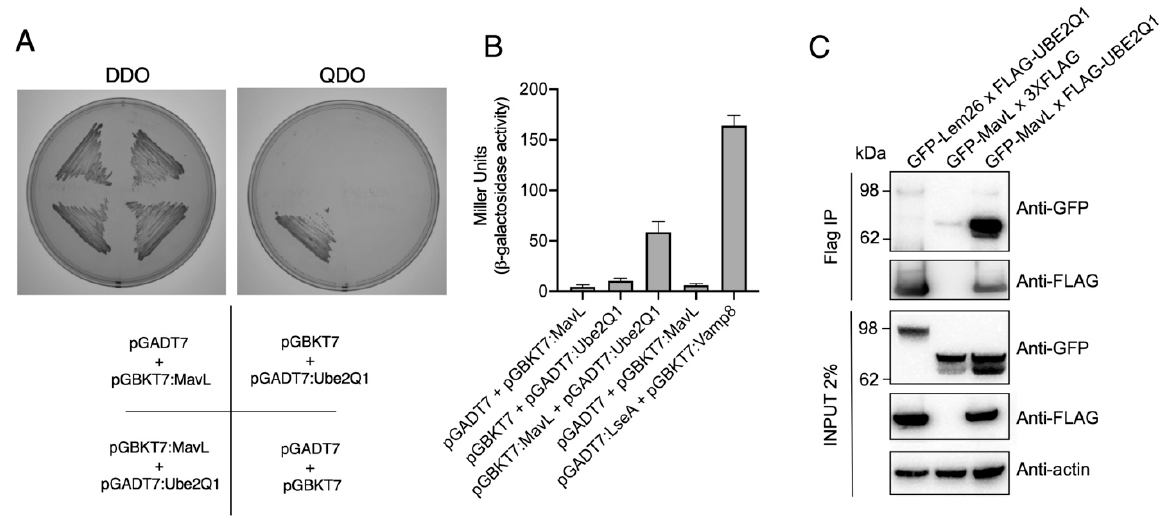
Figure 2. Protein-protein interaction between MavL and UBE2Q1. ( A ) Yeast two-hybrid analysis of protein-protein interactions in S. cerevisiae PJ69-4A. Growth on selective media for plasmid maintenance (DDO, double dropout) or selective media for interaction between proteins (QDO, quadruple dropout). Interactions on QDO shown for yeast strains carrying pGADT7:Ube2Q1 and pGBKT7:MavL. ( B ) β -galactosidase reporter activity for yeast strains shown in ( A ), and positive control carrying plasmids pGADT7:LseA and pGBKT7:Vamp8. LseA and Vamp8 are known interaction partners [13]. Activity is shown in Miller Units. ( C ) Immunoprecipitation of HEK293T cells transfected with pFLAG-UBE2Q1 and pGFP-MavL. Anti-FLAG immunoprecipitation was performed on cell lysates and eluates were subjected to immunoblot analysis with anti-GFP and anti-FLAG antibodies. The non-interacting partner GFP-Lem26 was included as a negative control. Actin, loading control.